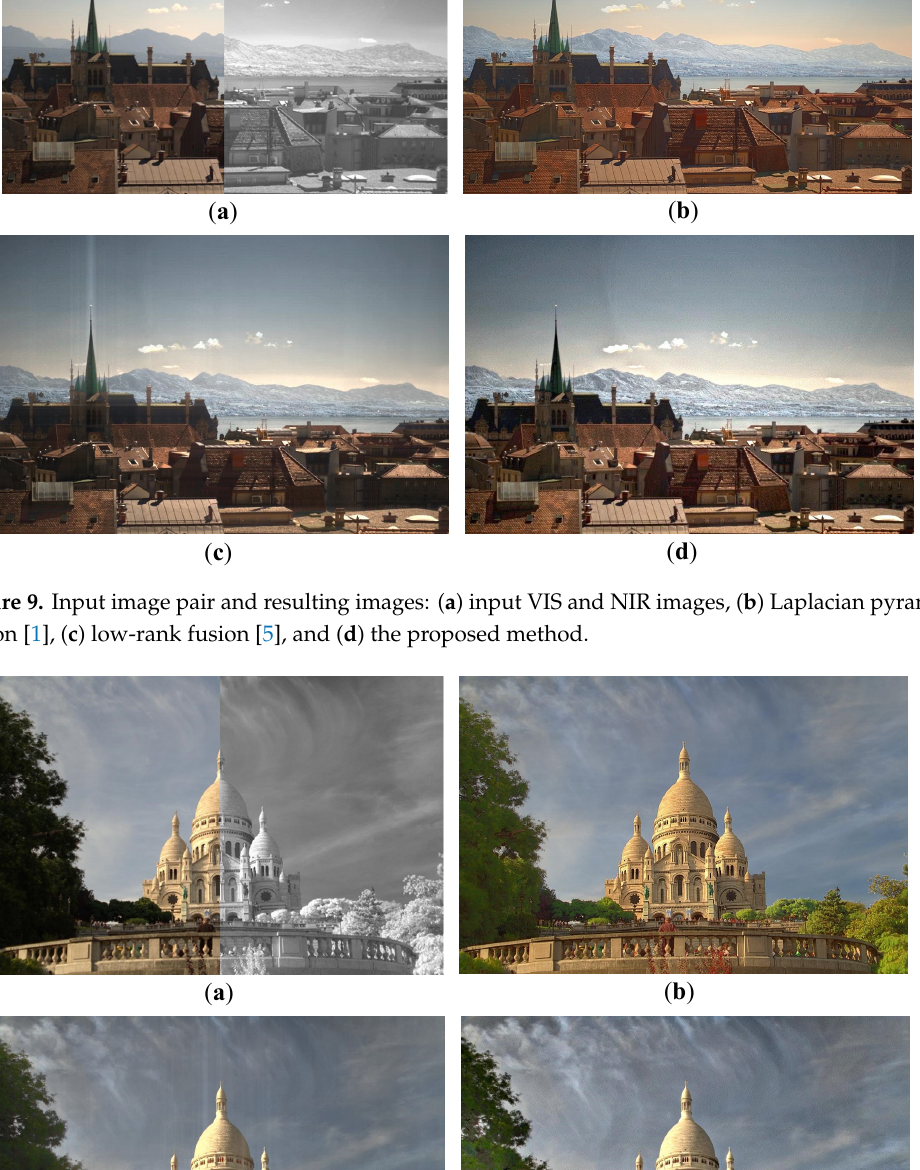
Figure 8. Input image pair and resulting images: (a) input VIS and NIR images, (b) Laplacian pyramid fusion [1], (c) low-rank fusion [5], and (d) the proposed method.